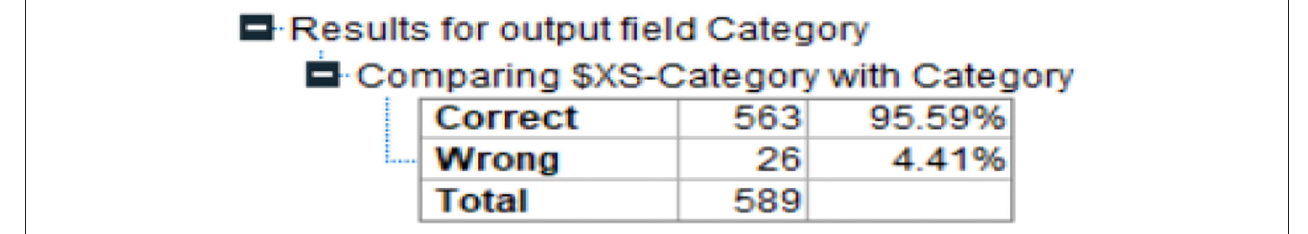
FIGURE 10 | Accuracy level of Proposed Ensemble learning model.